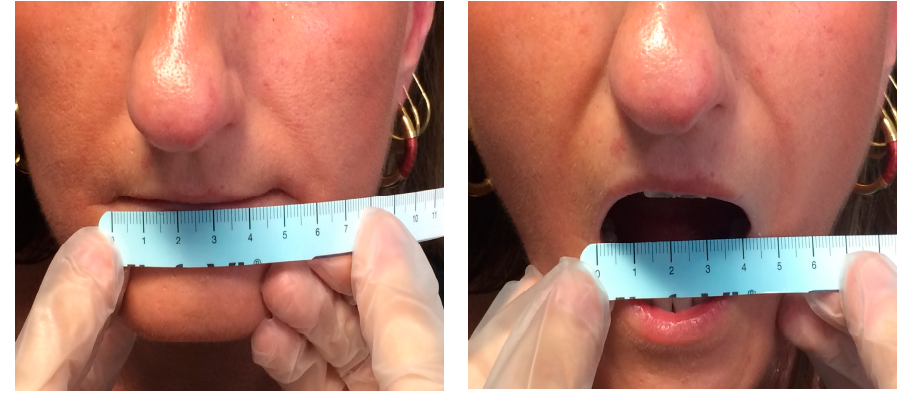
Figure 2. SSc patient. Microstomia has been measured as the distance between the lip commissures.